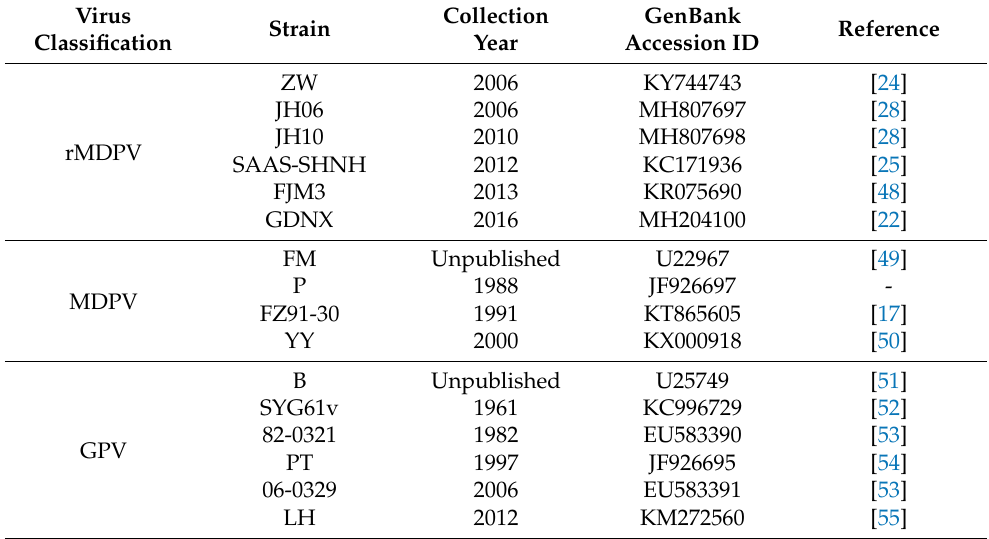
Table 3. Representative subsets of rMDPV, MDPV and GPV.